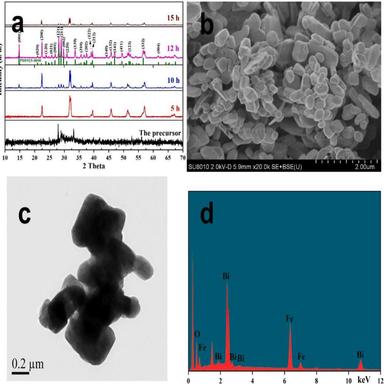
(a) XRD patterns of the obtained samples with different hydrothermal times. SM-BFO: (b) SEM, (c) TEM and (d) EDX.